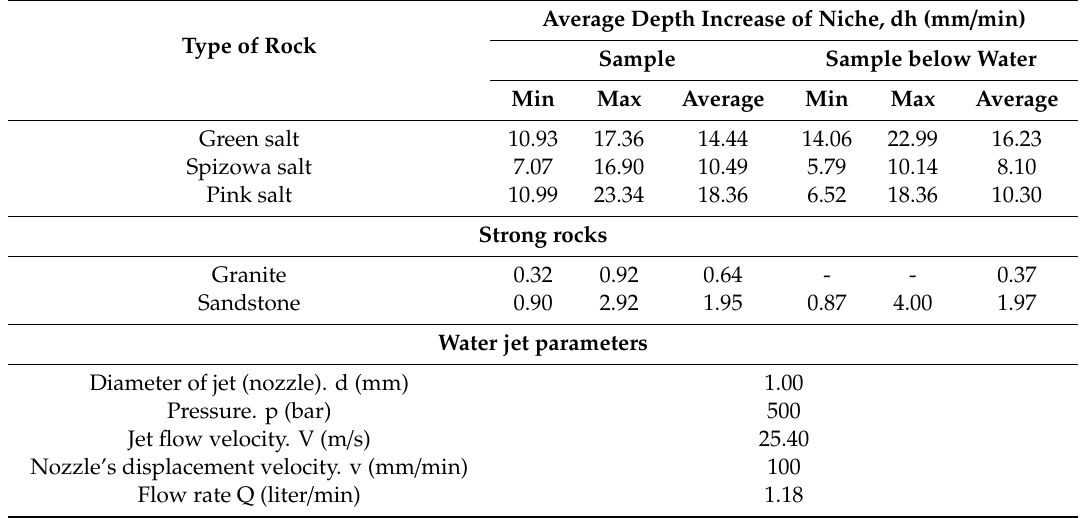
Table 8. Average depth increase of niches cut with water jet for various types of rocks. Average Depth Increase of Niche, dh (mm / min) Type of Rock Sample Sample below Water Min Max Average Min Max Average Green salt 10.93 17.36 14.44 Spizowa salt Strong rocks Granite 0.32 Sandstone 0.90 Water jet